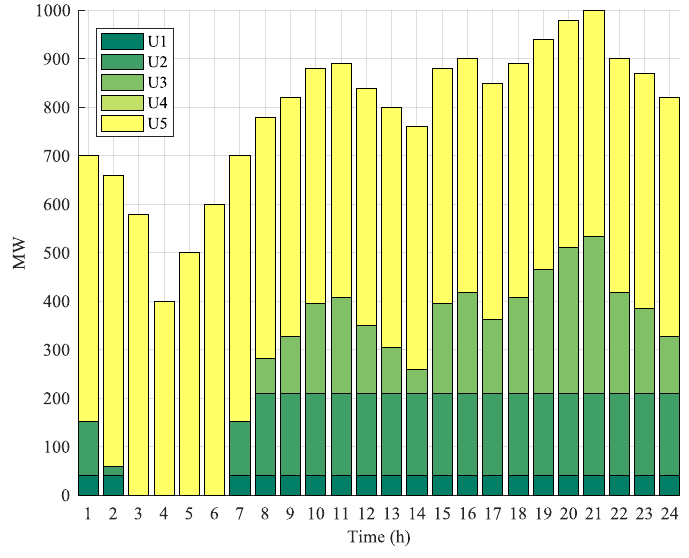
Figure 3. Units’ output power with transmission congestion.